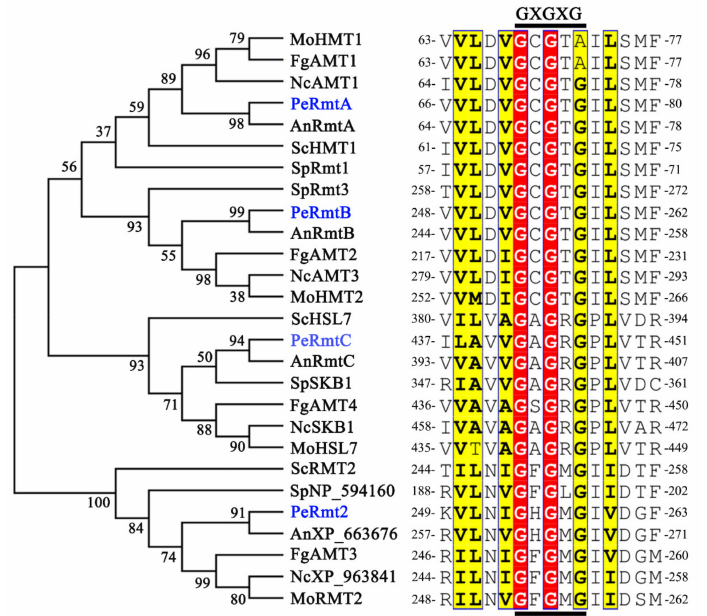
Figure 1. Phylogenetic analysis and conserved motif identification of PRMTs homologs in Penicillium expansum and six other fungal